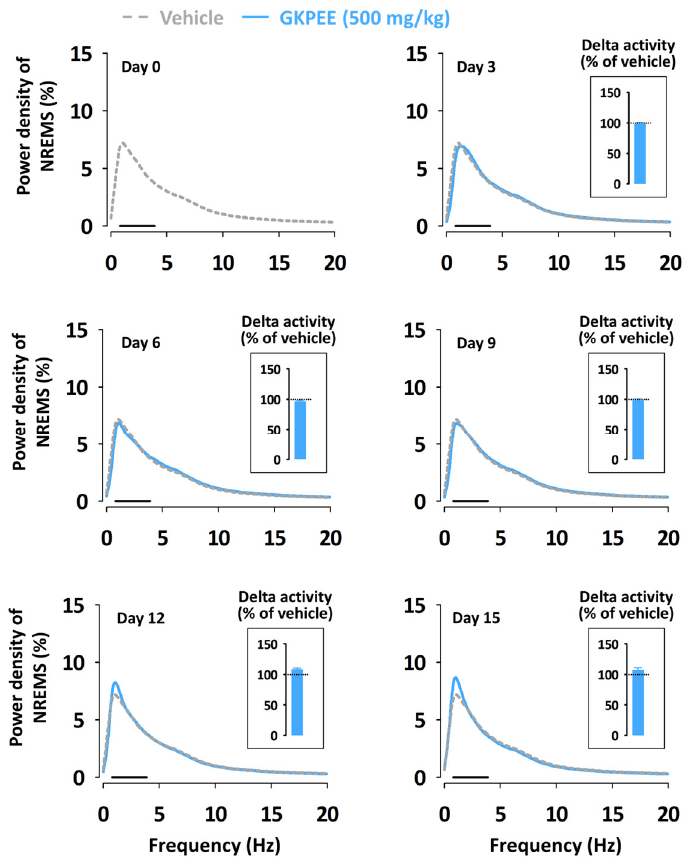
Figure 6. Effect of Sub-chronic (15-day) administration of GKPEE on EEG power density curves of NREMS. The bar (—) represents the range of the delta wave (0.5–4 Hz). GKPEE, green kiwifruit peel ethanol extract; NREMS, non-rapid eye movement sleep.